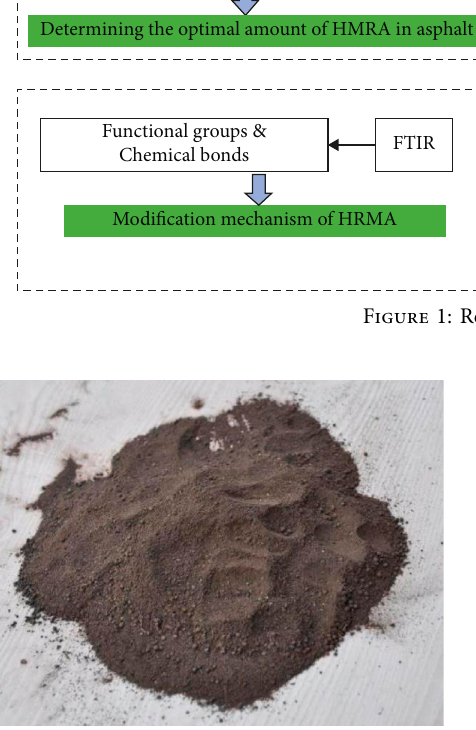
Figure 2: HRMA modifier. Table 1: Properties of high modulus agent